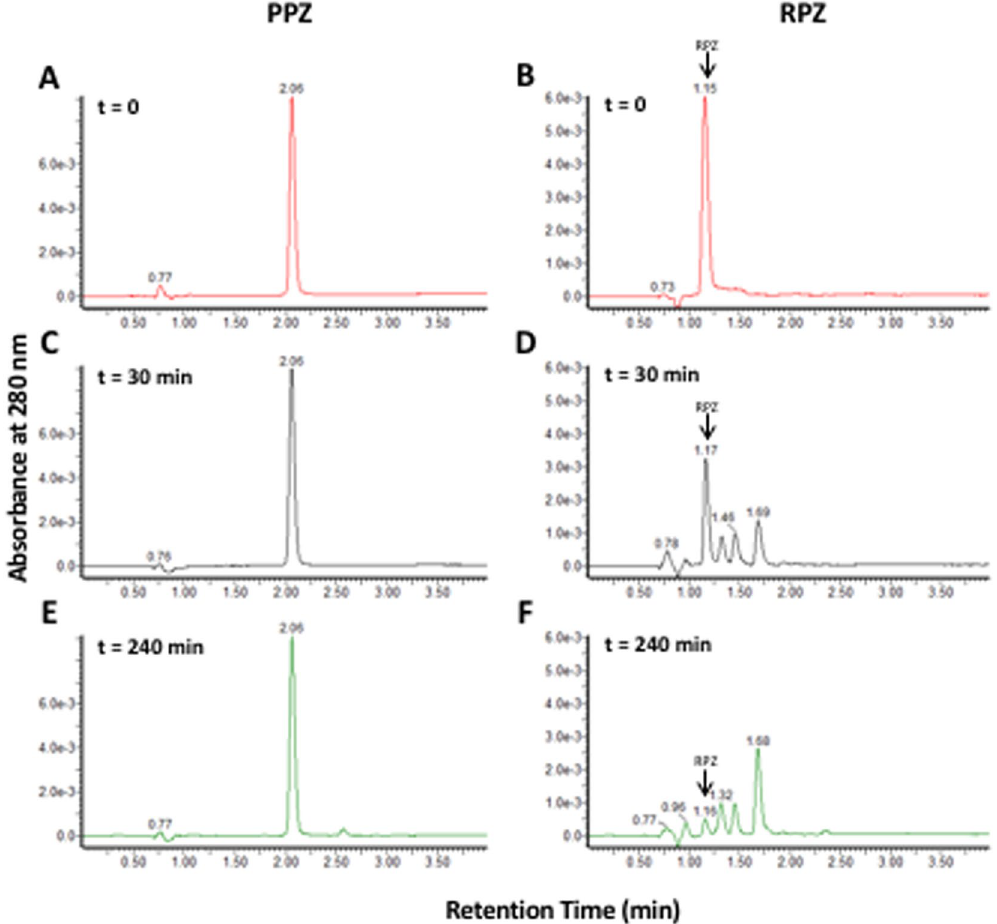
Figure 4. Detection of rabeprazole (RPZ) degradation products. UV chromatograms detected at 280 nm for pantoprazole (PPZ) and RPZ at time 0 ( A and B , respectively), after 30 min of incubation ( C and D , respectively) and after 4 h of incubation ( E and F , respectively). Additional peaks in RPZ chromatograms are attributed to RPZ degradation products and were identified using published mass spectral data 17 (data not shown). The arrow indicates the residual peak for